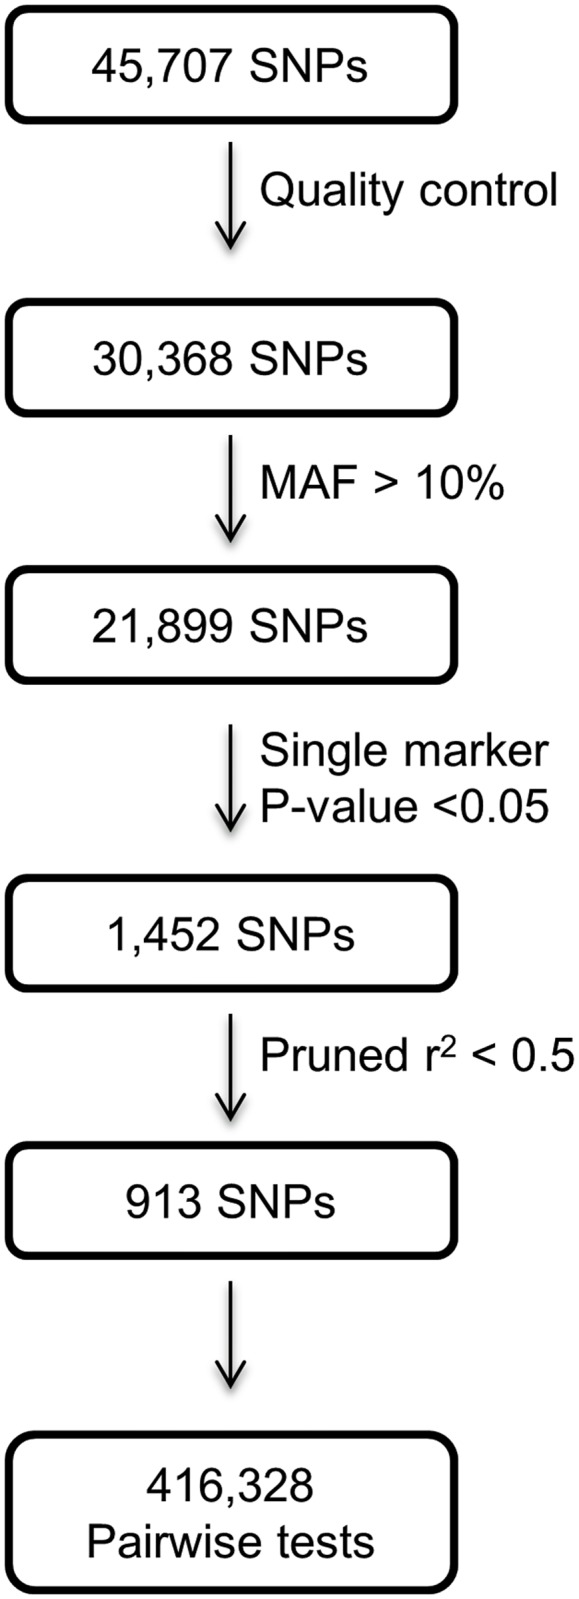
A schematic illustration of SNP selection process for the primary analysis.